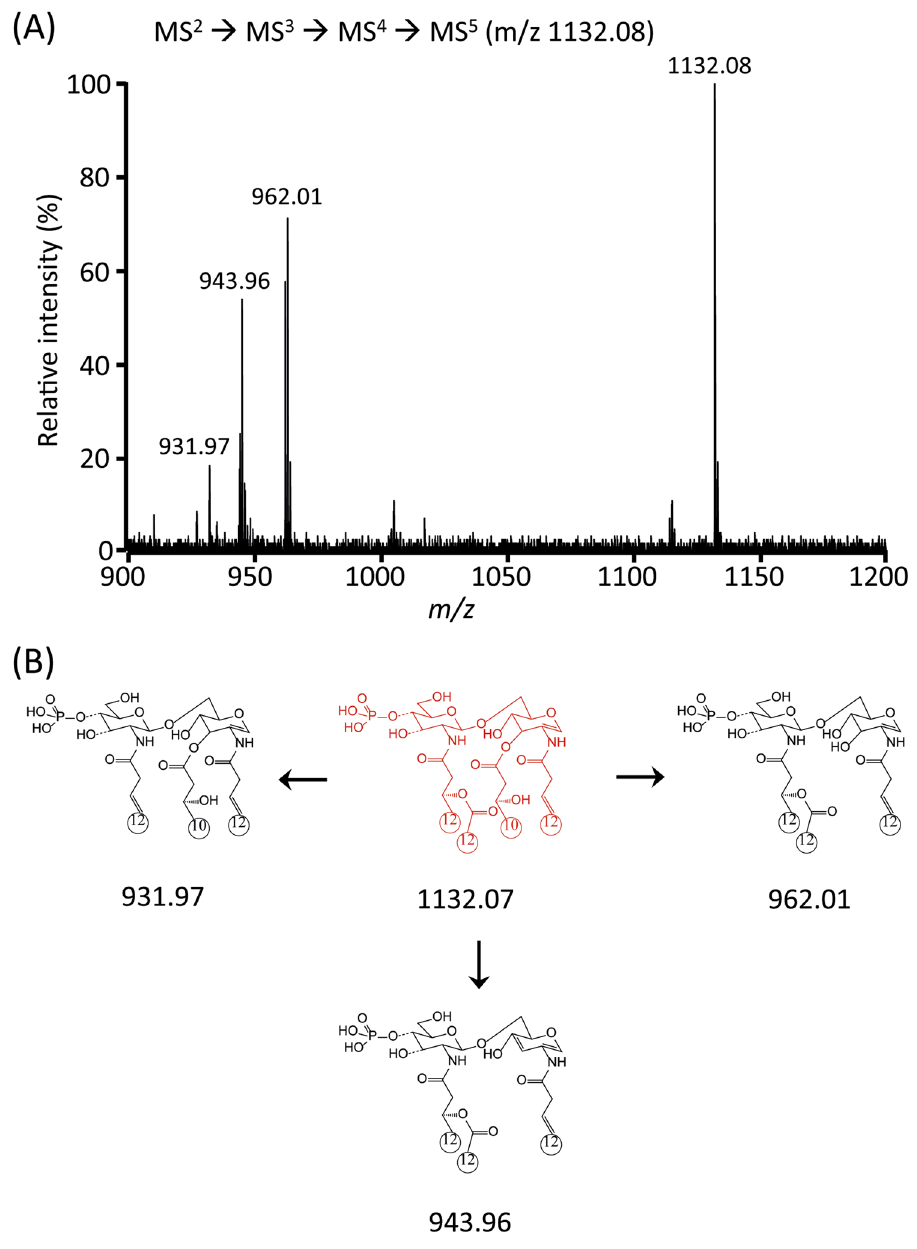
Figure 7. Negative-ion MALDI-MS 5 spectrum of m/z 1132.08 ( A ) and fragment structure ( B